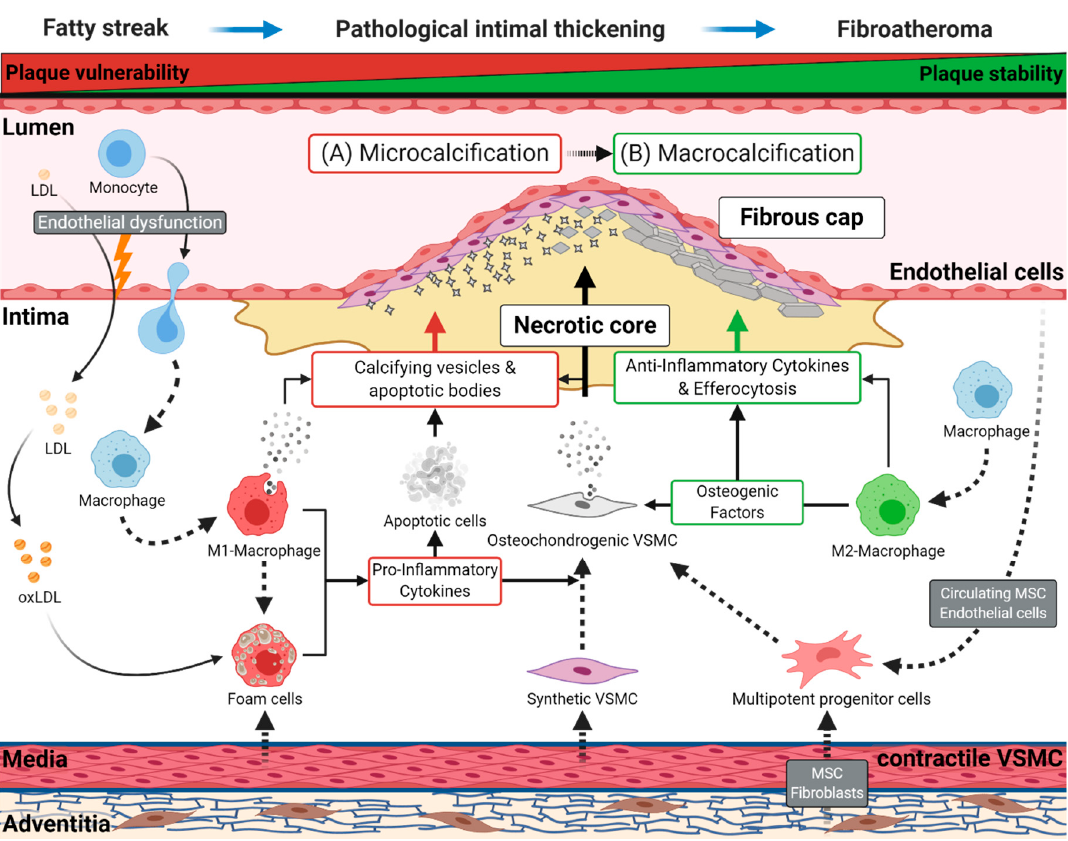
Figure 1. Schematic representation of atherogenesis and intimal vascular calcification. Endothelial dysfunction promotes retention of low-density lipoprotein (LDL) in the intima and the diapedesis of monocytes. Subsequently, retained LDL transforms to oxidized LDL (oxLDL), and monocytes migrating to the intima differentiate into macrophages. Later, these cells can switch to pro-inflammatory M1 or anti-inflammatory M2 macrophages. Resting macrophages and M1 macrophages can absorb oxLDL, which converts them into foam cells. These cells start forming the lipid-rich, necrotic core of the atherosclerotic plaque, which first occurs as a fatty streak in the vessel wall, the earliest sign of